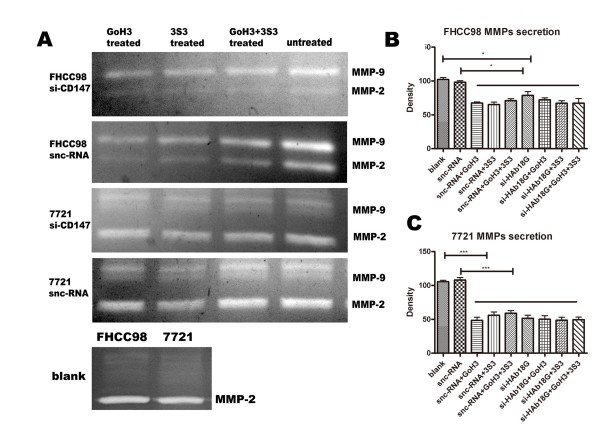
MMP secretion of hepatoma cells with or without integrin α6β1 mAbs and siHAb18G/CD147 treatment. MMP levels of FHCC98 (A, B) and 7721 (A, C) cells. Bars represent the mean of triplicate samples; error bars represent standard deviation. Data are representative of three independent experiments. ***P < 0.01, * P < 0.05 versus corresponding cells with no antibody treatment.